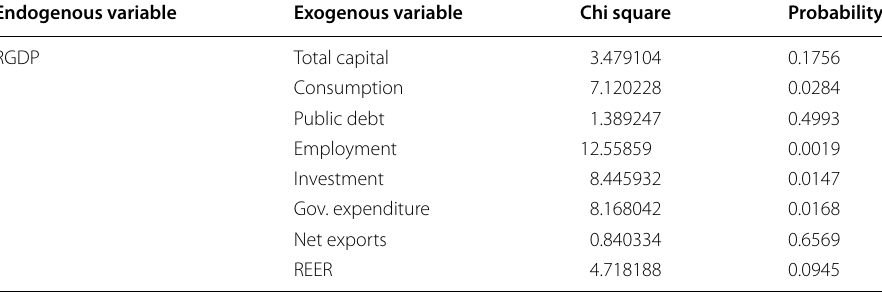
Table 6 Wald test results for Eq. (2). Source : Author’s